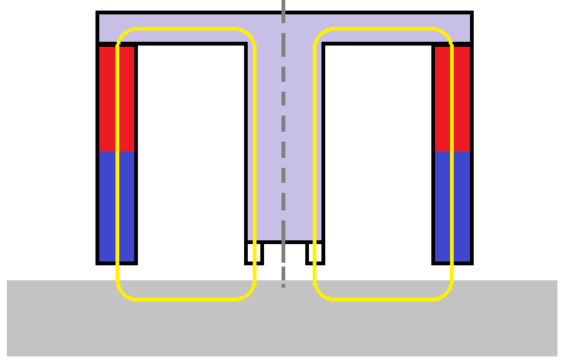
Figure 25. New configuration cross-section with two magnetic circuits.